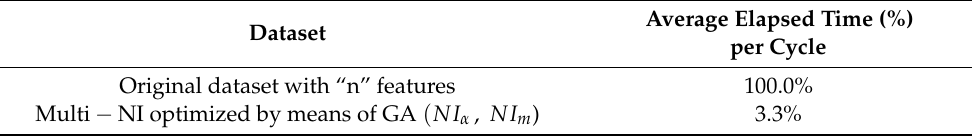
Table 5. Processing times of the classification with different reduced